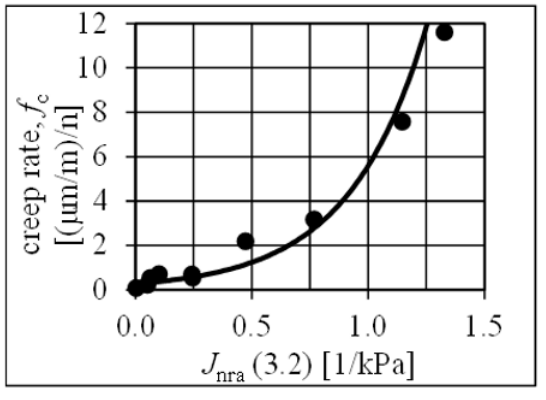
Figure 2. CorrelationbetweencreeprateofAC16asphaltmixesand average non-recoverable compliance of different